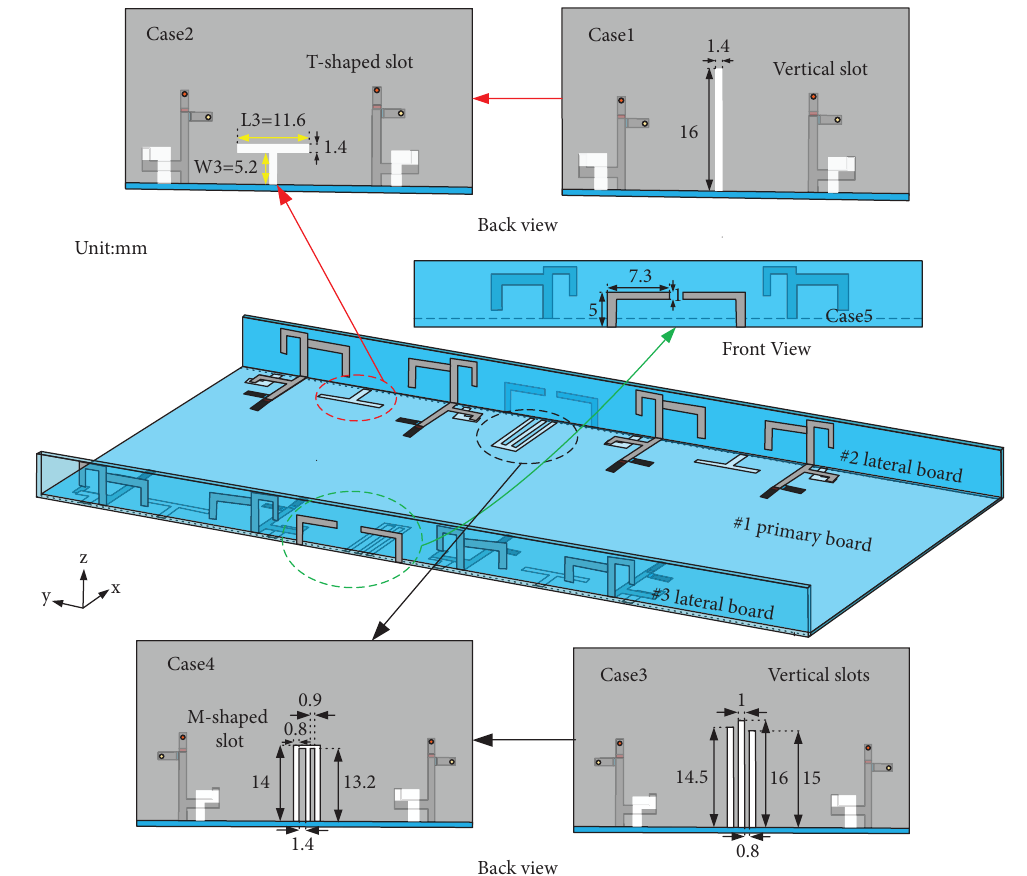
Figure 9: Design and detailed dimensions of the proposed decoupling